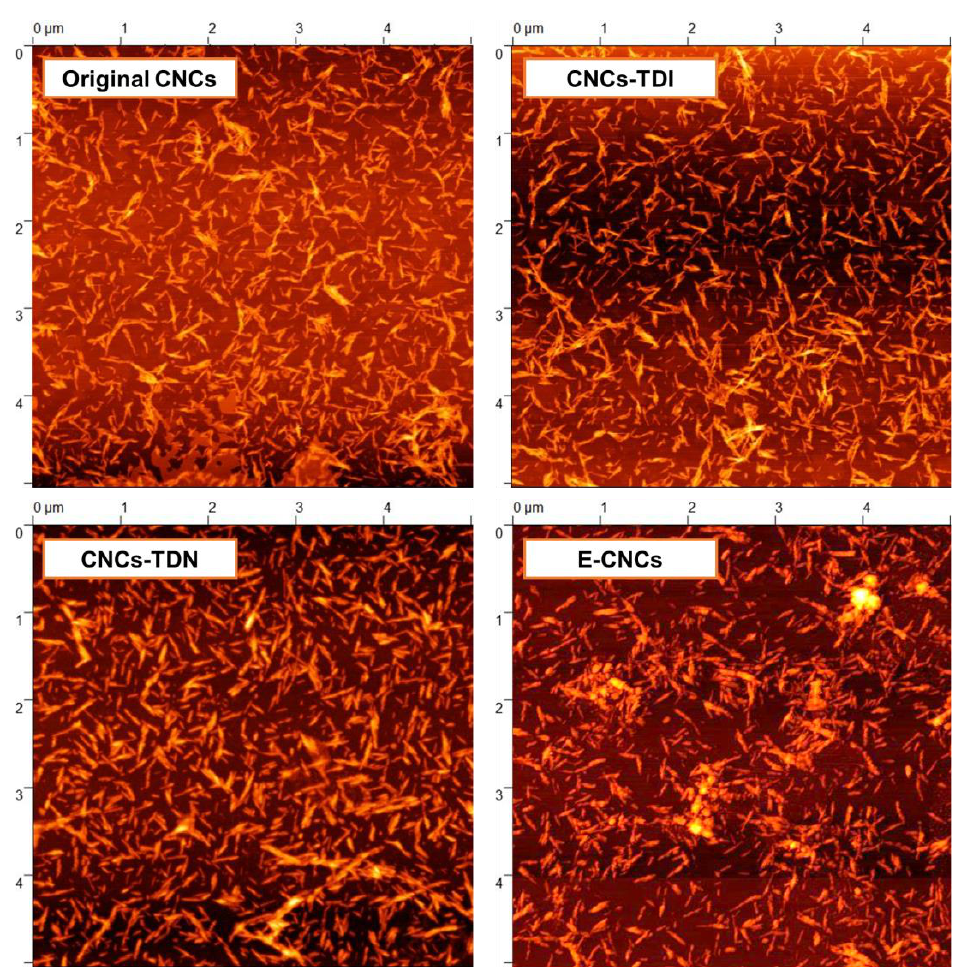
Figure 7. AFM topography images of the original CNCs, after carbamation using 2,4-TDI (CNCs-TDI), hydrolysis using HCl-acidified DMSO (CNCs-TDN), and after polymerization using APS (E-CNCs).